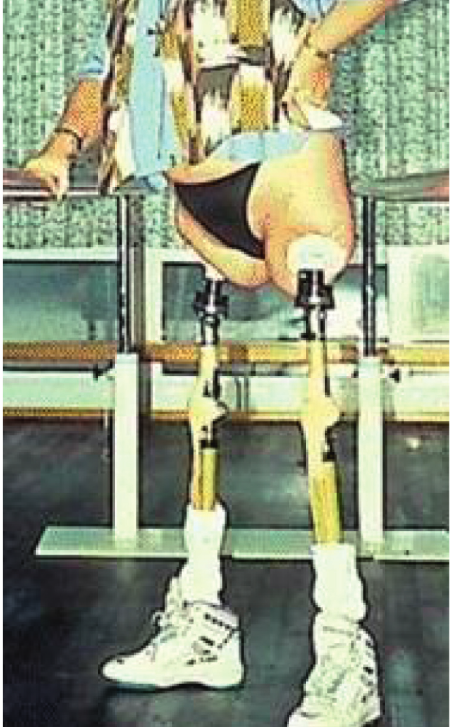
Figure 2: The first patient with long-term successful transcuta- neous limb osseointegration. The surgery was performed on 15 May, 1990, by Rickard Br˚anemark in Sweden, for a young woman who lost both legs due to a street car accident. Despite her relatively short residual limbs, she is able to stand on two prosthetic legs and no compressive socket is needed. This procedure ushered in the current era of transcutaneous osseointegration for amputees (TOFA) (reproduced with permission from Li, Y., Br˚anemark, R. Osseointegrated prostheses for rehabilitation following ampu- tation. Unfallchirurg 120, 285–292 (2017).